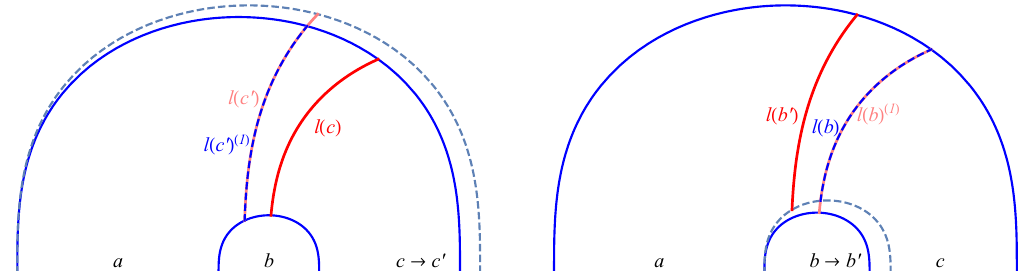
Figure 13 . Left plot: the cartoon for the proof of inequality (A.1). Two blue curves are C b ; C a;b;c respectively, and the dashed curve in light blue is C a;b;c 0 . The red and pink curve are the minimum cross-sections for ( a; b; c ), ( a; b; c 0 ) with EoP as l ( c ) ; l ( c 0 ), respectively. The blue dashed curve is the segment of the minimum cross-section for ( a; b; c ) with length l ( c 0 ) (1) . Right plot: the cartoon for the proof of inequality (A.2). Two blue curves correspond to C b ; C a;b;c respectively. The dashed light blue curve is C a;b 0 ;c . The red and pink curve are the minimum cross-sections for ( a; b 0 ; c 0 ), ( a; b; c ) with EoP as l ( b 0 ) ; l ( b ), respectively. The blue dashed curve is the segment of the minimum cross-section for ( a; b; c ) with length l ( b 0 ) (1)